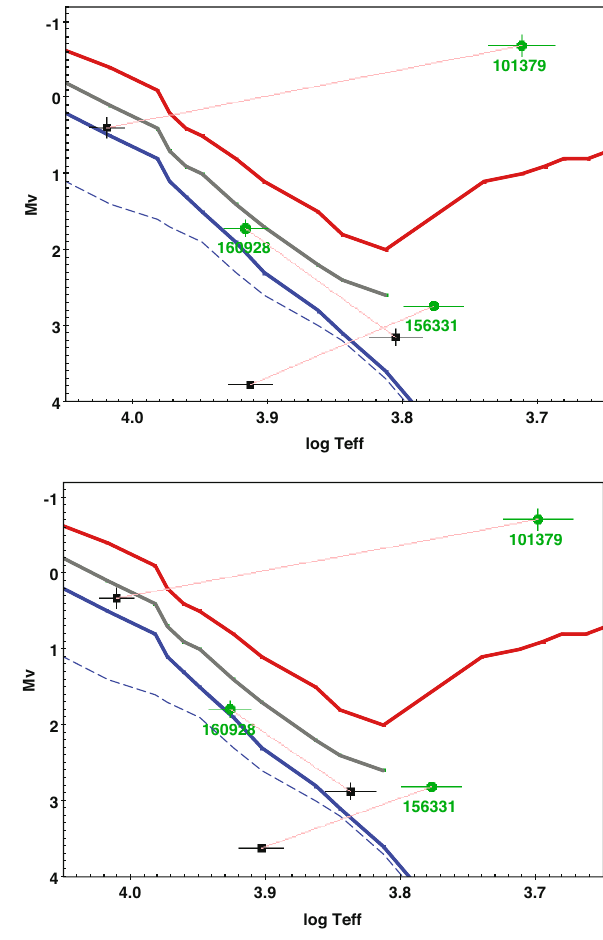
Figure 2: HD 101379, HD 156331, and HD 160928 systems on the HRD. The solid curves represent the main sequence, subgiant, and giant sequences ( blue, gray and red, respectively ) , while the dashed blue curve represents ZAMS ( Strai ž ys 1992 ) . Green circles andblack squares represent primary ( more luminous ) and secondary components of the binaries,respectively, with uncertaintybars. CoelhoandPhoenix stellar modelsare shown in the top and bottom panels,